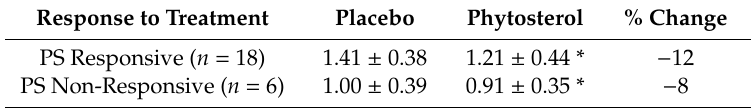
Table 5. Endothelin-1 plasma concentration of subjects according to LDL-c response to phytosterol intake.